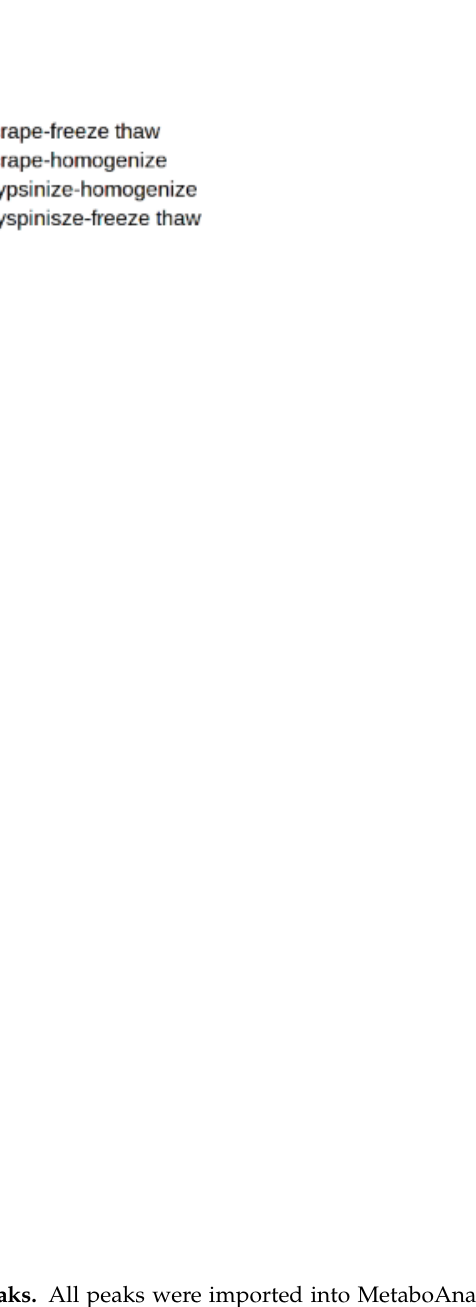
Figure 4. Heatmap of all metabolomics peaks. All peaks were imported into MetaboAnalyst to visualize the peak abundances across different sample preparation methods. The detachment method showed the largest difference in metabolome profiles as compared to the lysis method.